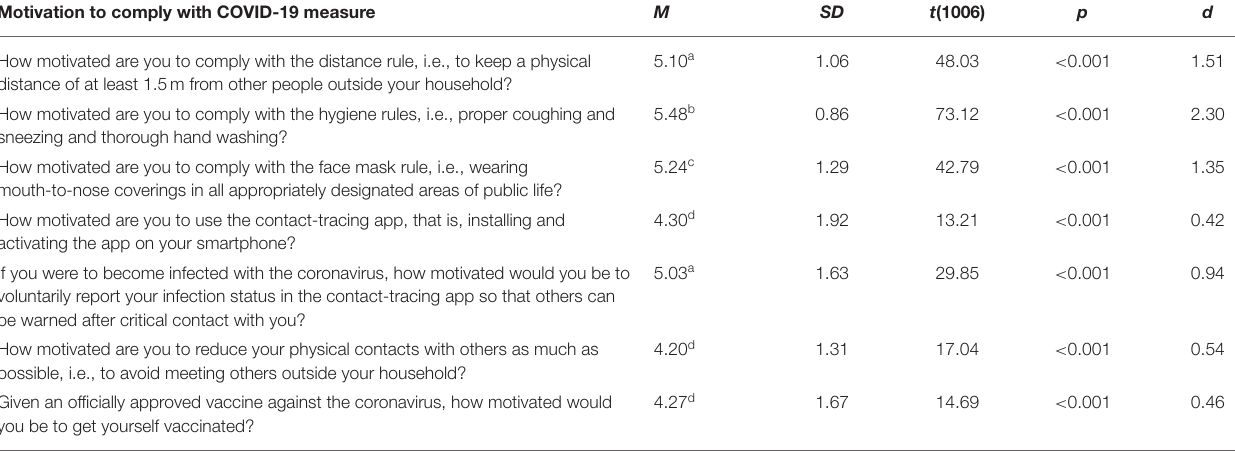
TABLE 1 | Descriptive and inferential statistics for participants’ motivation to comply with COVID-19 measures. Motivation to comply with COVID-19 measure M SD t (1006) p